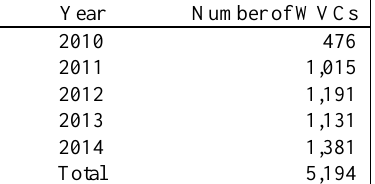
Table 1 Annually reported WVCs for the district of Straubing-Bogen